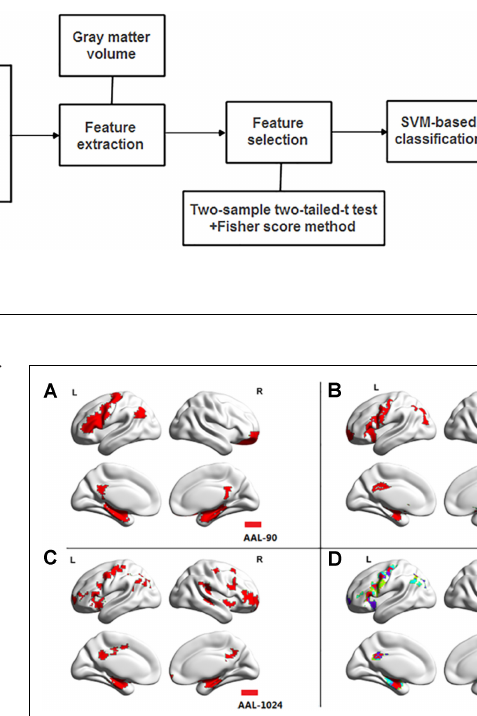
FIGURE 3 | The atrophic brain regions in three atlases, respectively. (A) The abnormal brain regions in AAL-90; (B) the abnormal brain regions in BN-246; (C) the abnormal brain regions in AAL-1024; (D) the overlapping abnormal regions among